Question: According to this chart, does the measure grow or shrink?
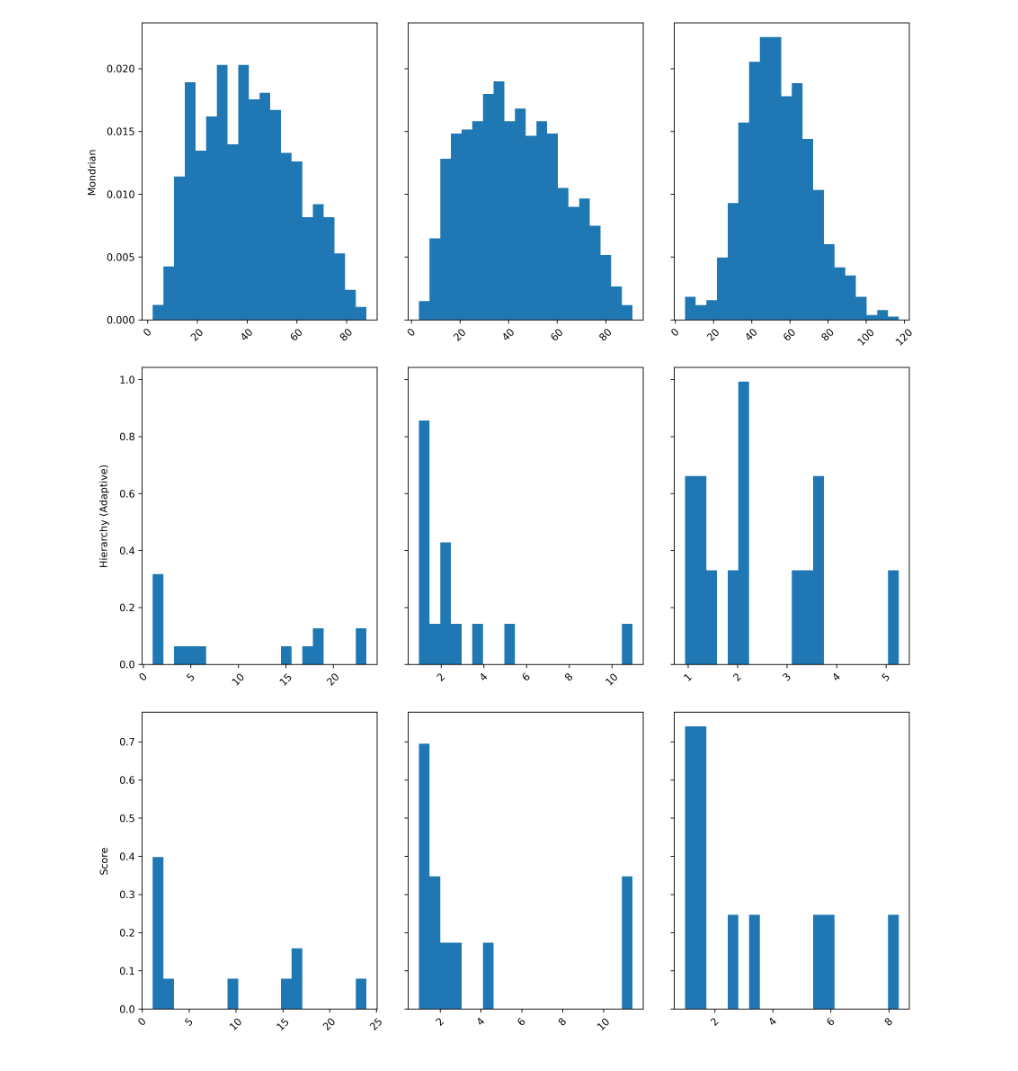
Answer: increasing